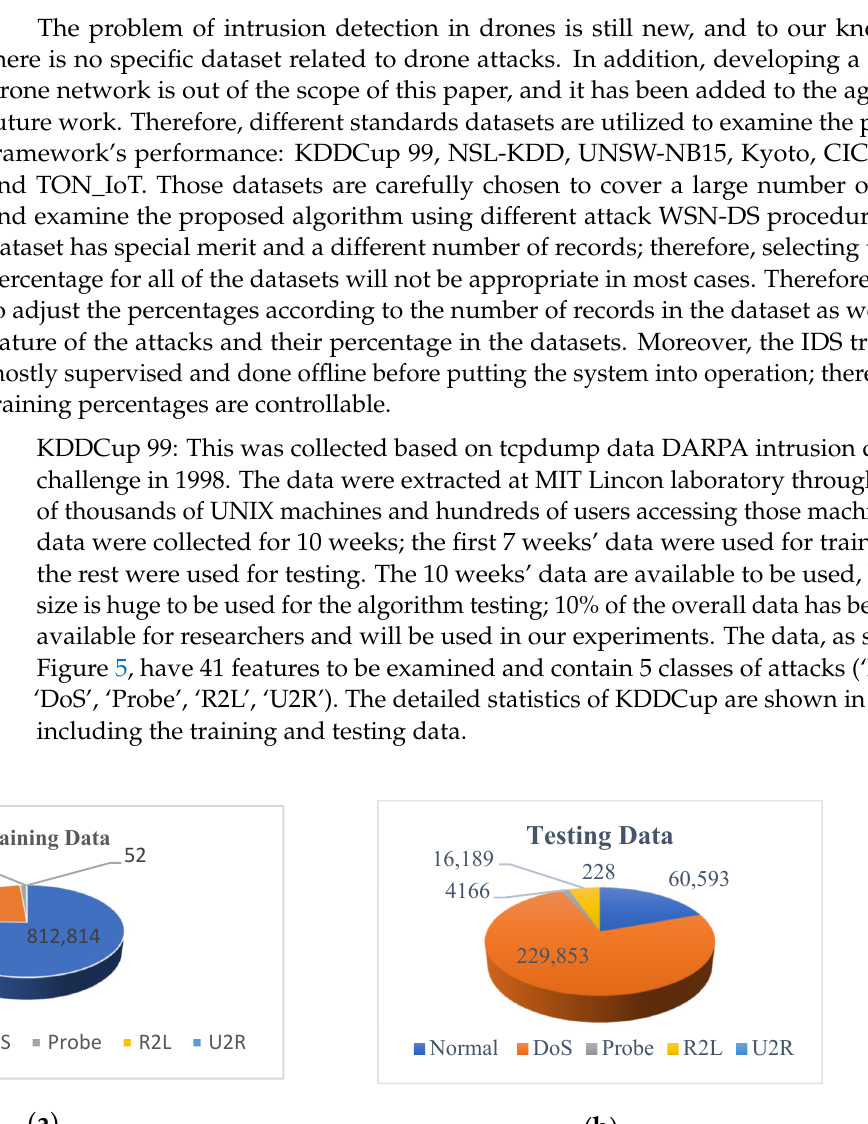
( b ) Figure 6. NSL-KDD ( a ) training data and ( b ) testing data. •